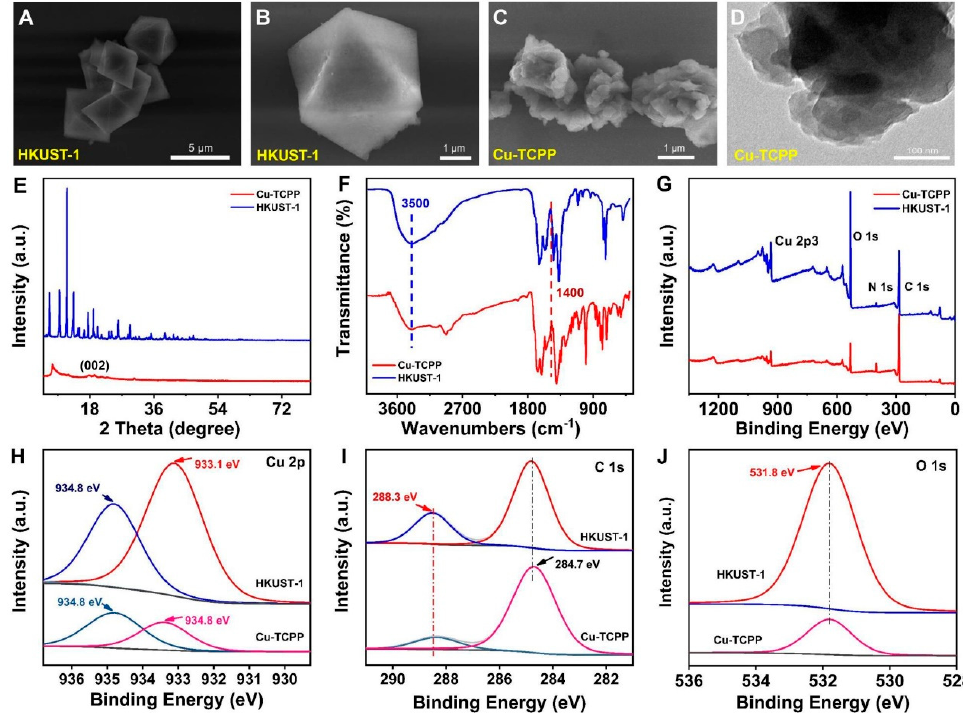
Figure 1. ( A , B ) SEM image of HKUST-1. ( C ) SEM image of Cu-TCPP. ( D ) TEM image of Cu–TCPP. ( E ) XRD patterns and ( F ) FT-IR spectra of HKUST-1 and Cu-TCPP. ( G ) XPS survey spectra for HKUST-1 and Cu-TCPP. High-resolution XPS spectra of ( H ) Cu 2p, ( I ) C 1s and ( J ) O 1s for HKUST-1 and Cu-TCPP.